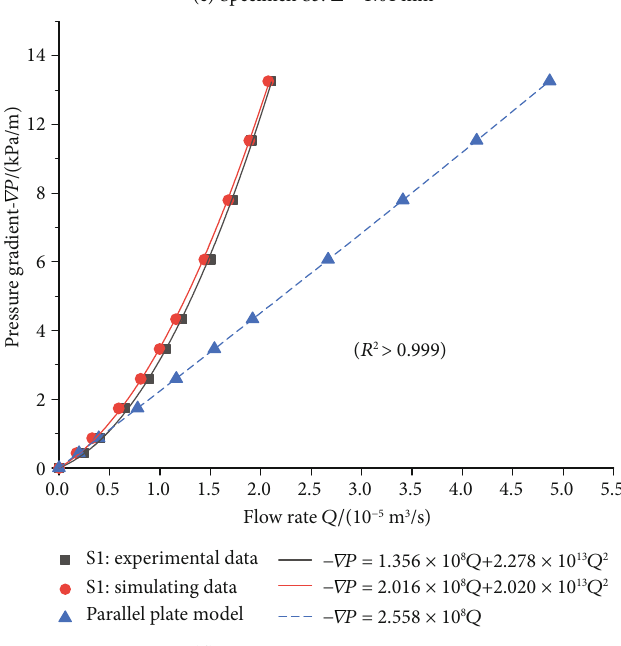
Figure 4: Curves of ∇ P − Q for specimens